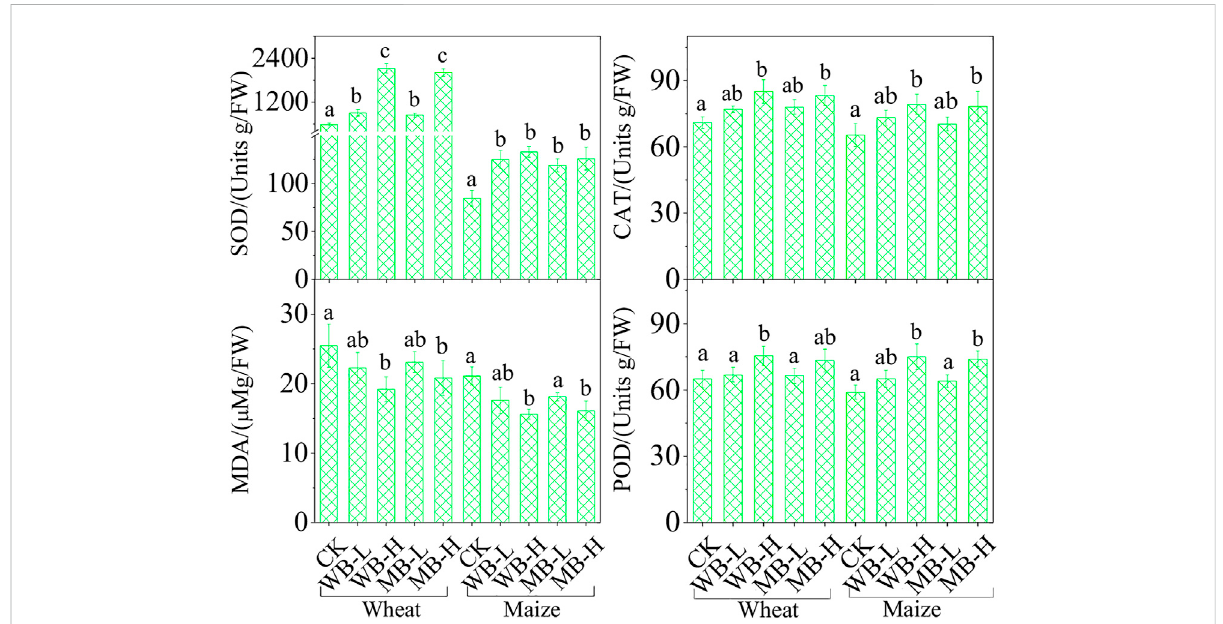
FIGURE 3 Effects of biochar on SOD, CAT, MDA, and POD activities in wheat and maize.